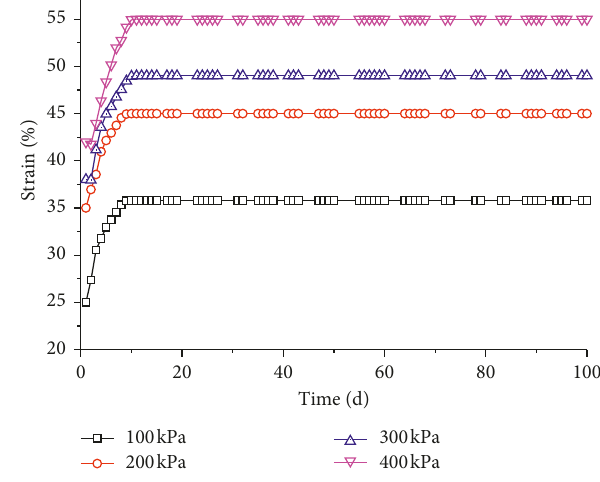
Figure 4: Compression test data of MSW.